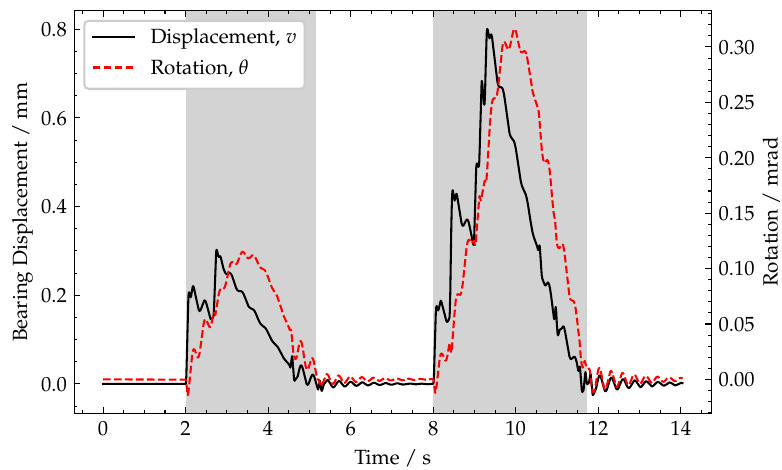
Figure 4. Plot of end of span rotation and end of span vertical (bearing) displacement. Periods when a vehicle is crossing the bridge are shaded grey.